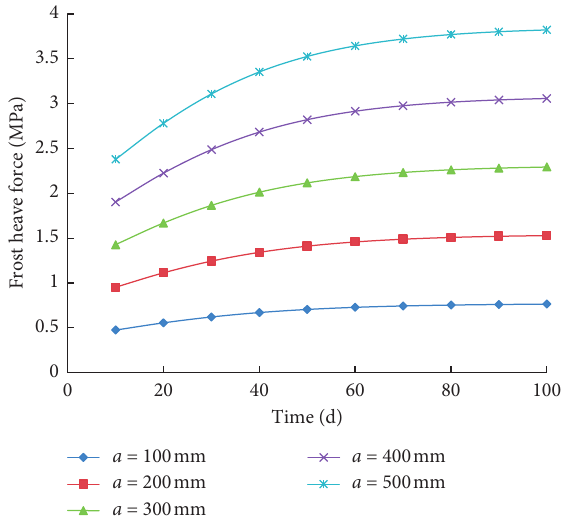
Figure 7: Frost heaving force-time curve under different cavity sizes.